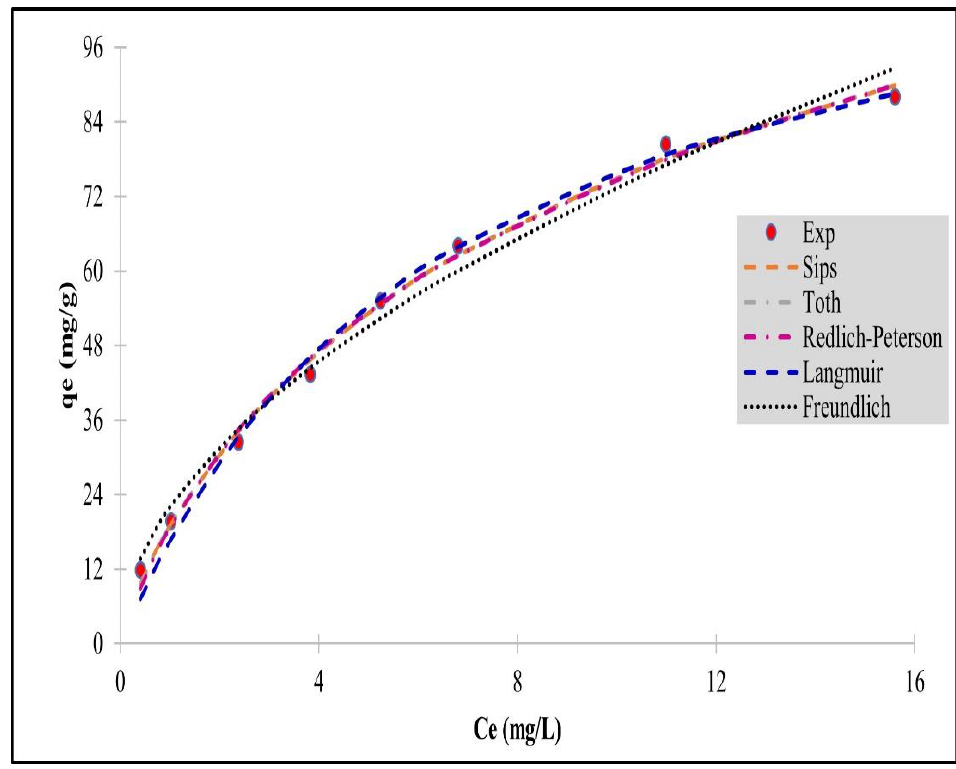
Figure 1. Five isotherm models compared with the experimental IBU equilibrium data.